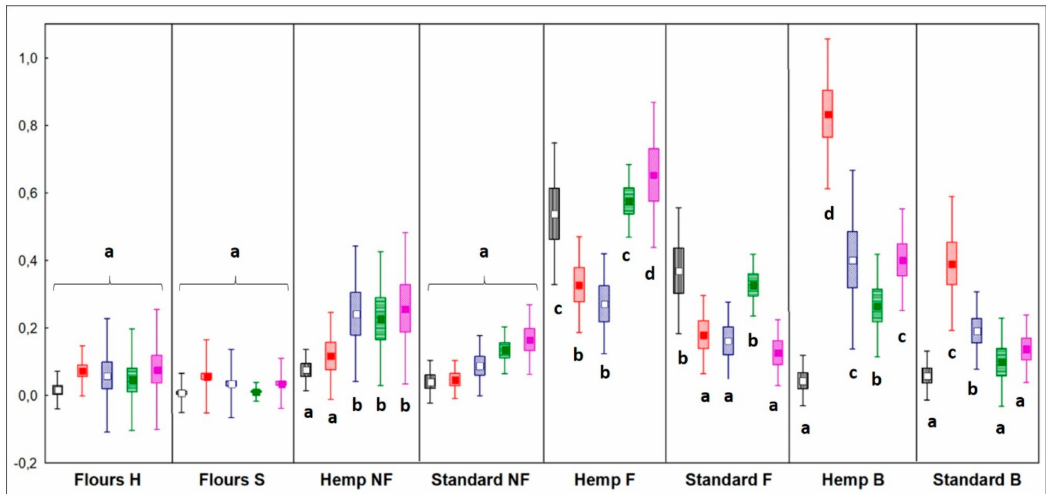
Figure 1. Relative quantification of total volatile organic compounds (VOCs) divided by chemical classes. Di ff erent letters indicate di ff erent significance values by Tukey’s HSD test ( p < 0.05). Sample abbreviations: H = hemp seed enriched; S = standard; NF = not fermented; F = fermented; B = breads. Box = mean value; Rectangles = mean ± Standard Deviation (SD); Whiskers = mean + 1.96*SD. Black plots = alcohols; red plots = aldehydes; blue plots = ketones; green plots = organic acids; fuchsia plot = alkenes.